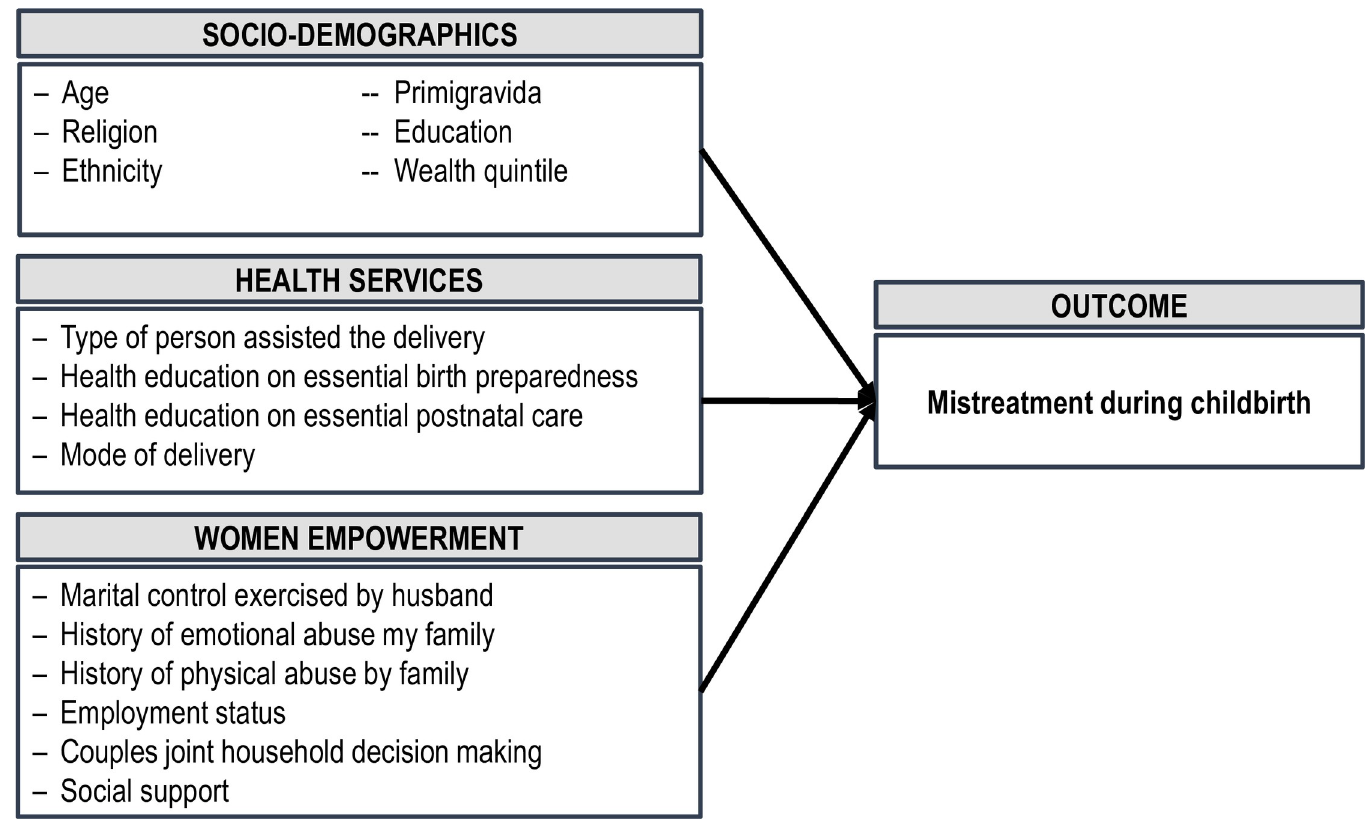
Fig 1. Analytical